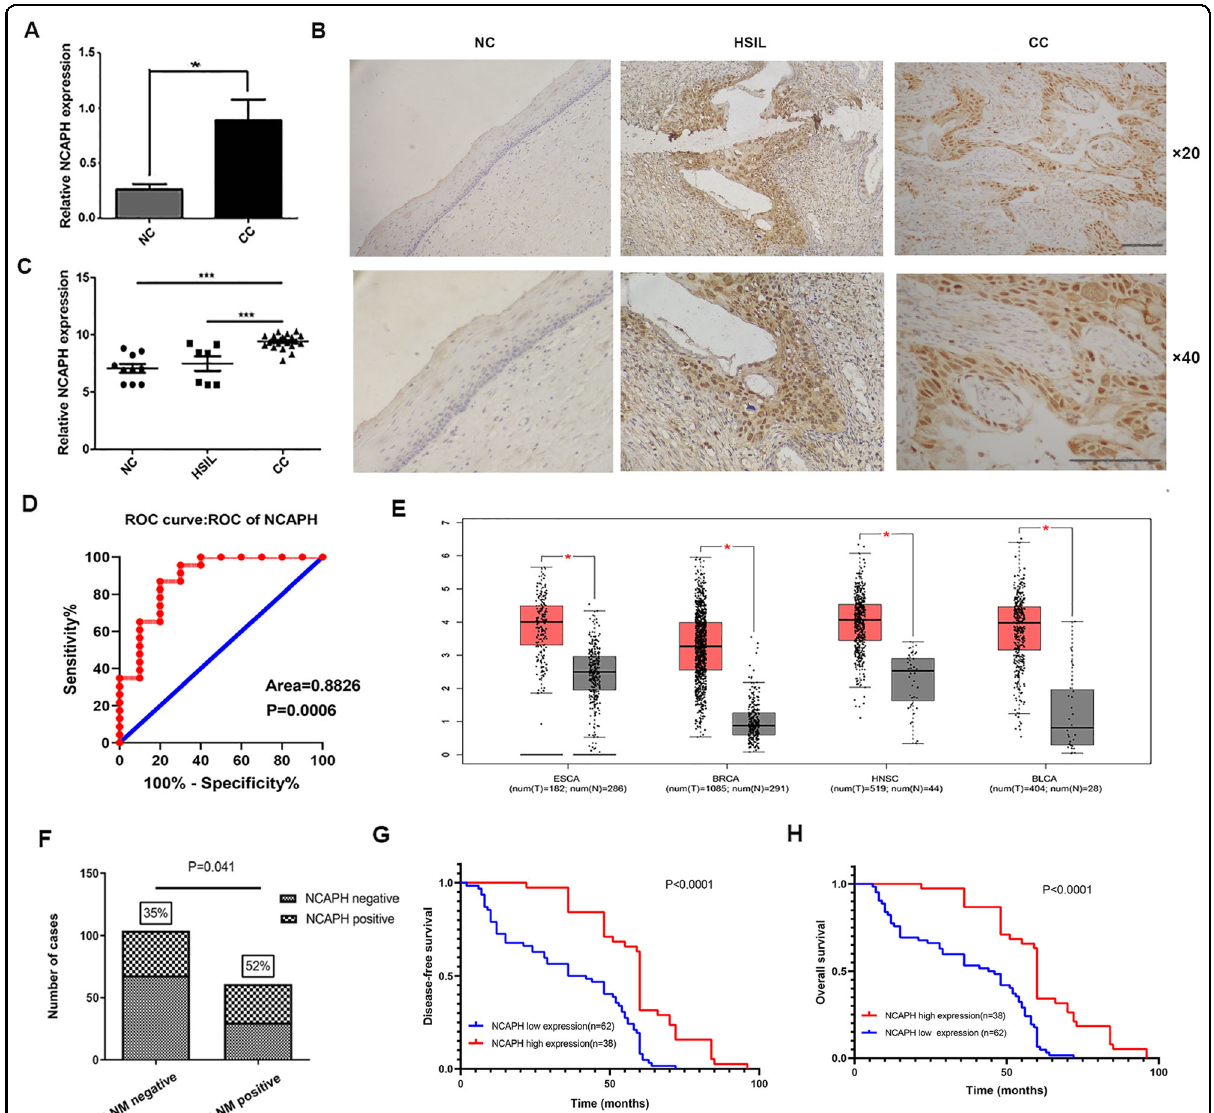
Fig. 1 The expression of NCAPH in cervical cancer and its association with patients ’ prognosis. A The mRNA level of NCAPH in cervical cancer (CC) ( n = 22) and normal cervix (NC) ( n = 10) analyzed by real-time PCR. Data are presented as mean ± SD ( n = 3). B , C) Immunohistochemical staining of NCAPH in normal cervix (NC) ( n = 82), high-grade squamous intraepithelial lesion (HSIL) ( n = 34) and invasive cervical cancer (ICC) ( n = 165). Scale bars, 100 μ m. D ROC curves showed the clear separation between normal cervix and cervical cancer tissues, with an area of 0.8826 ( p = 0.0006). E NCAPH expression in several solid tumors analyzed by GEPIA data base. Normal, normal tissues; ESCA, esophageal carcinoma; BRCA, breast invasive adenocarcinoma; HNSC, head and neck squamous cell carcinoma and BLCA, bladder urothelial carcinoma. F Compared with LNM-negative cervical cancer ( n = 104), NCAPH displayed higher expression rate in LNM-positive tissues ( n = 61) ( p = 0.0041). Kaplan – Meier curves for survival of 100 patients with cervical carcinoma. Culminative disease-free survival ( G ) and overall survival ( H